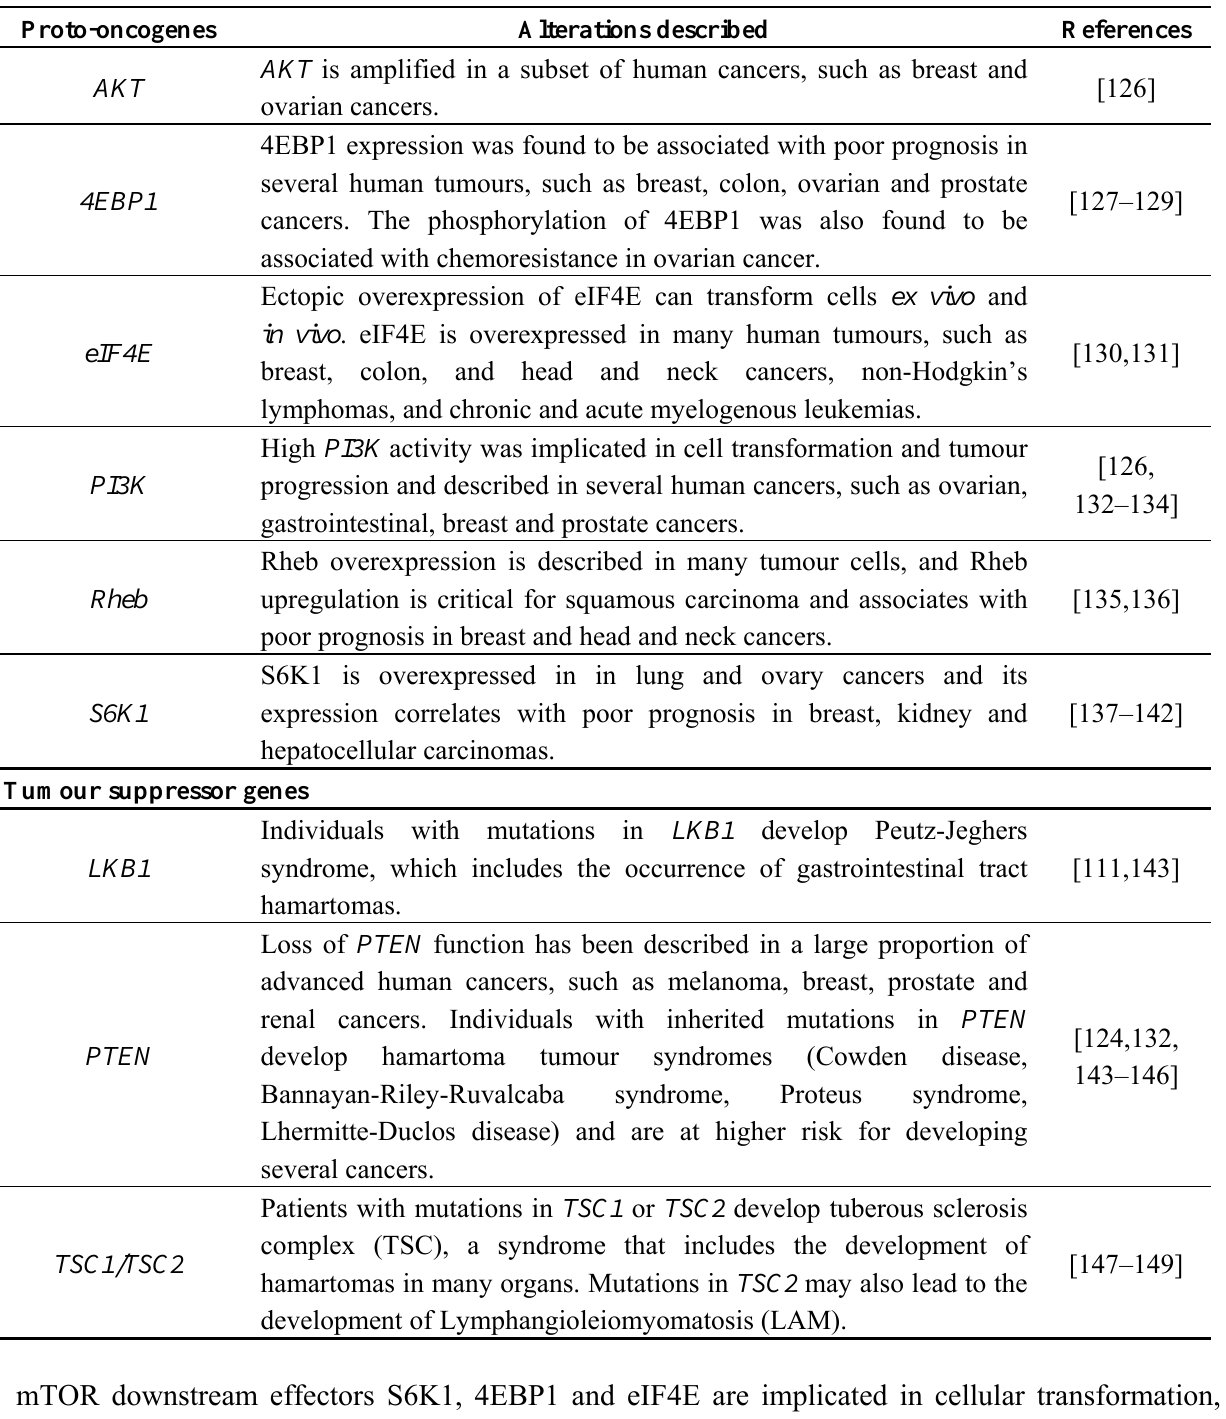
Table 1. Proto-oncogenes and tumour suppressor genes linked to the mTOR pathway.